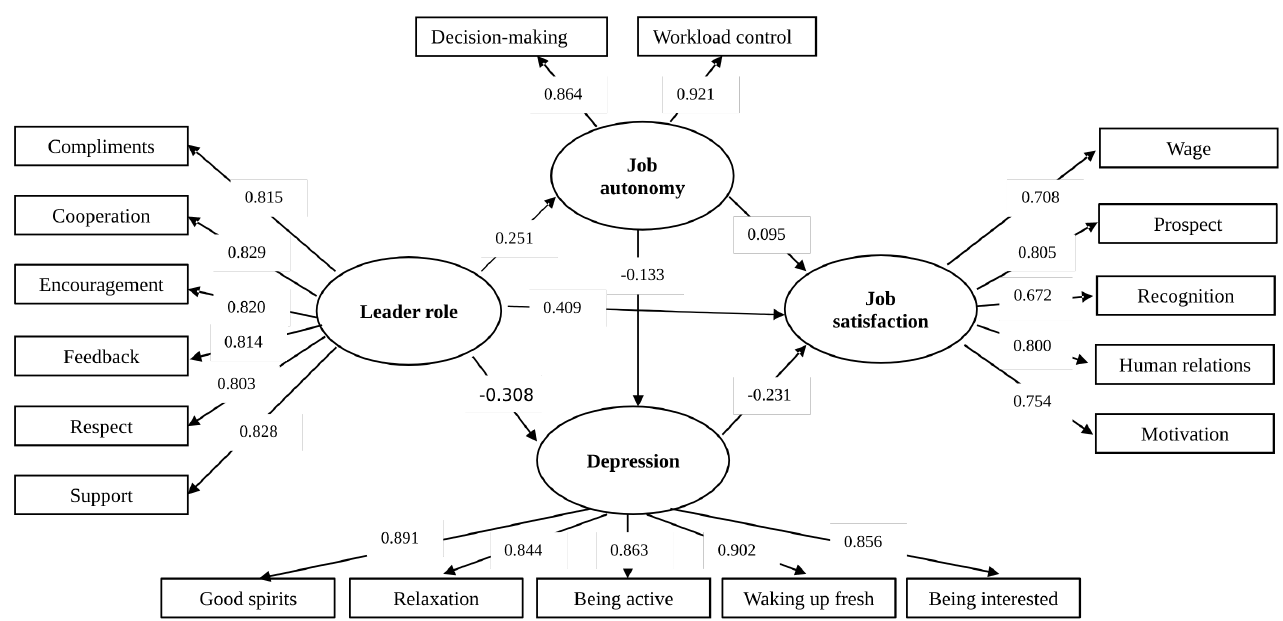
Fig. 3. Structural model for non-regular